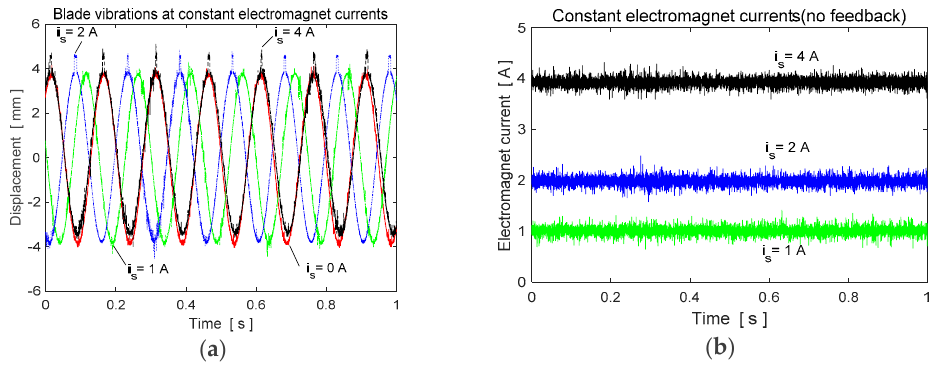
Figure 4. Experimental results at constant magnetic field ( a ) blade vibrations, ( b ) electromagnet currents.